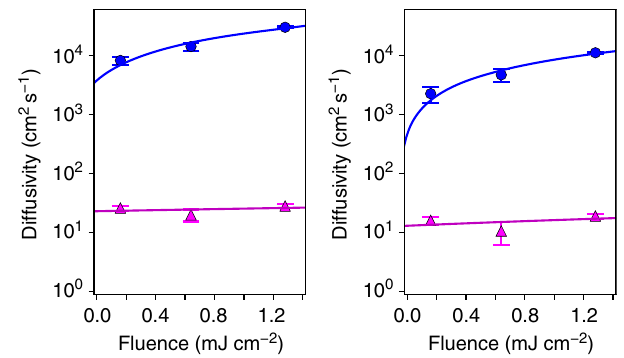
Figure 4 | Laser fluence dependence. Diffusivity as a function of laser fluence for electrons (left panel) and holes (right panel). The diffusivity values are given for the two different transport regimes found here, namely, ultrafast super diffusion (blue circles) and slow diffusion (magenta triangles). Linear fits of the data are also shown. The error bars are the s.d. obtained from the linear fit of R 2 (cid:3) (cid:4) versus time in the contrast images. The results are the average of three separate